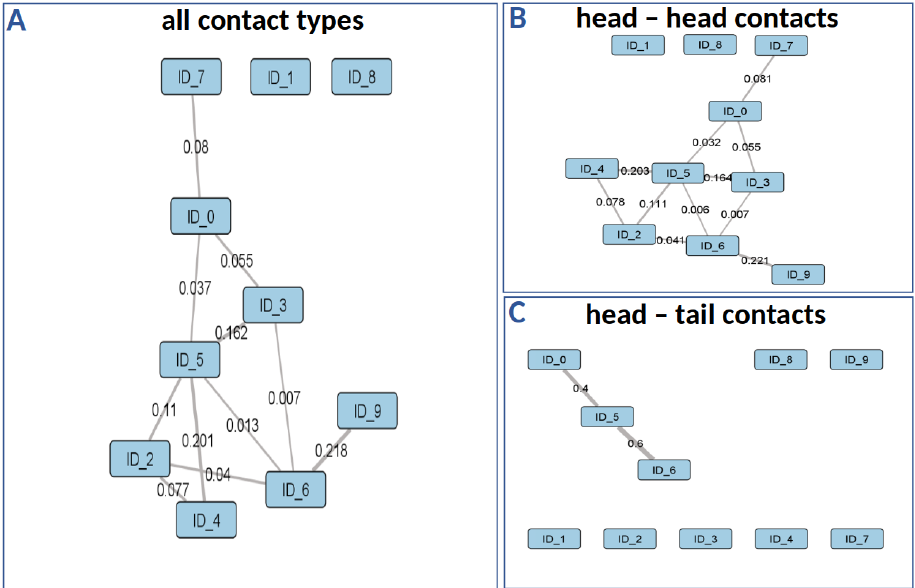
Figure 11. Examples of three social networks from one test